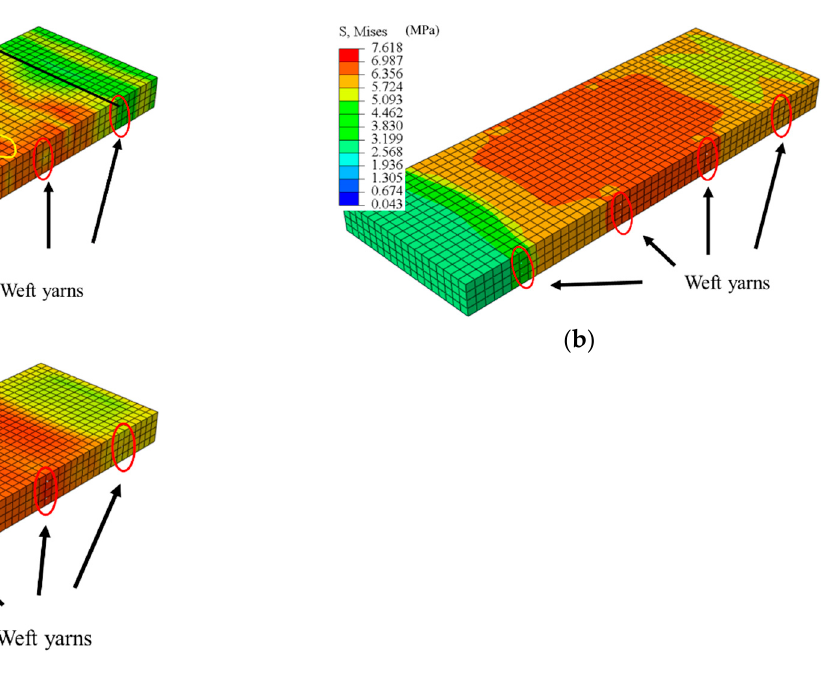
Figure 16. Stress distribution for different BFRP grid layers: ( a ) one-layer grid, ( b ) two-layer grid, and ( c ) three-layer grid.